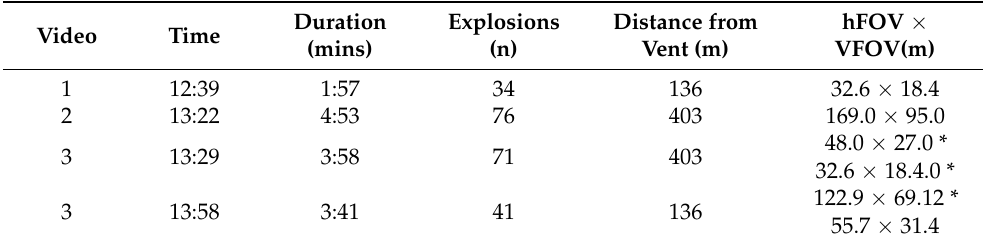
Table 1. Main characteristics of the video recorded on 25/02/2022 and its analysis. hFOV = Hor- izontal Field of View, vFOV = Vertical Field of view, * the focal length of the optics was changed during recording.